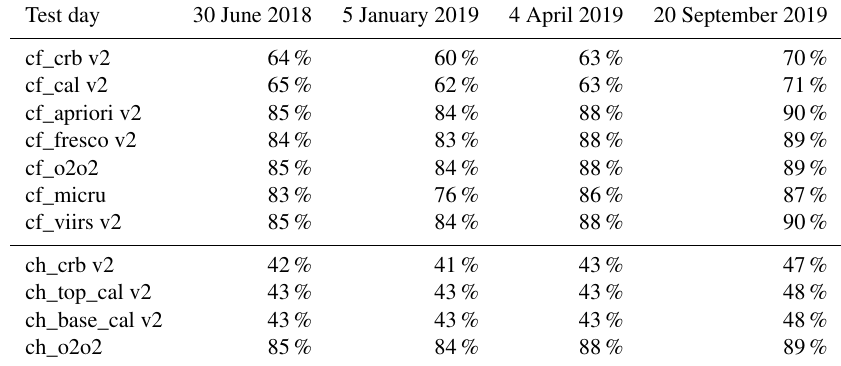
Table B4. As Table B1 but